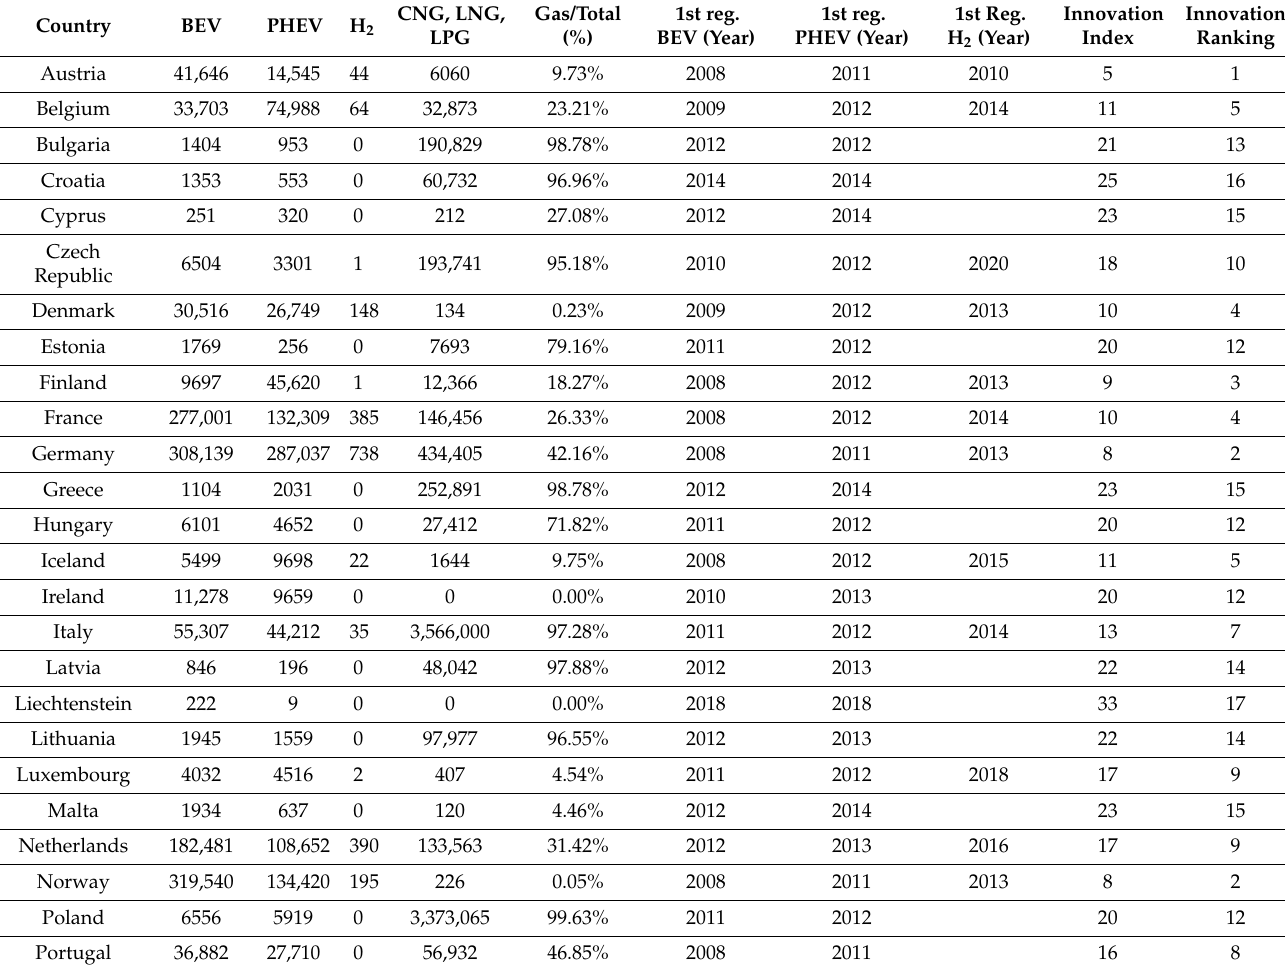
Table 1. Number of registered vehicles with alternative drive and evaluation of innovation, based on the moment of introducing selected types of drives to the market. Data for the European Union countries for 2020 based on EAFO [13].